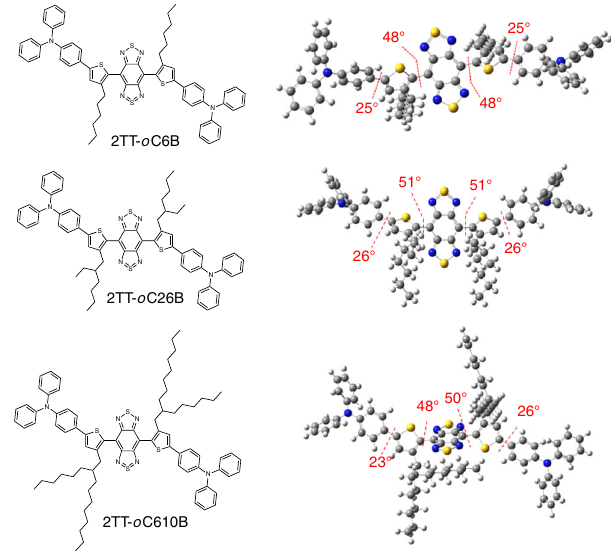
Fig. 2 Chemical structures and optimized ground state ( S 0 ) geometries of the